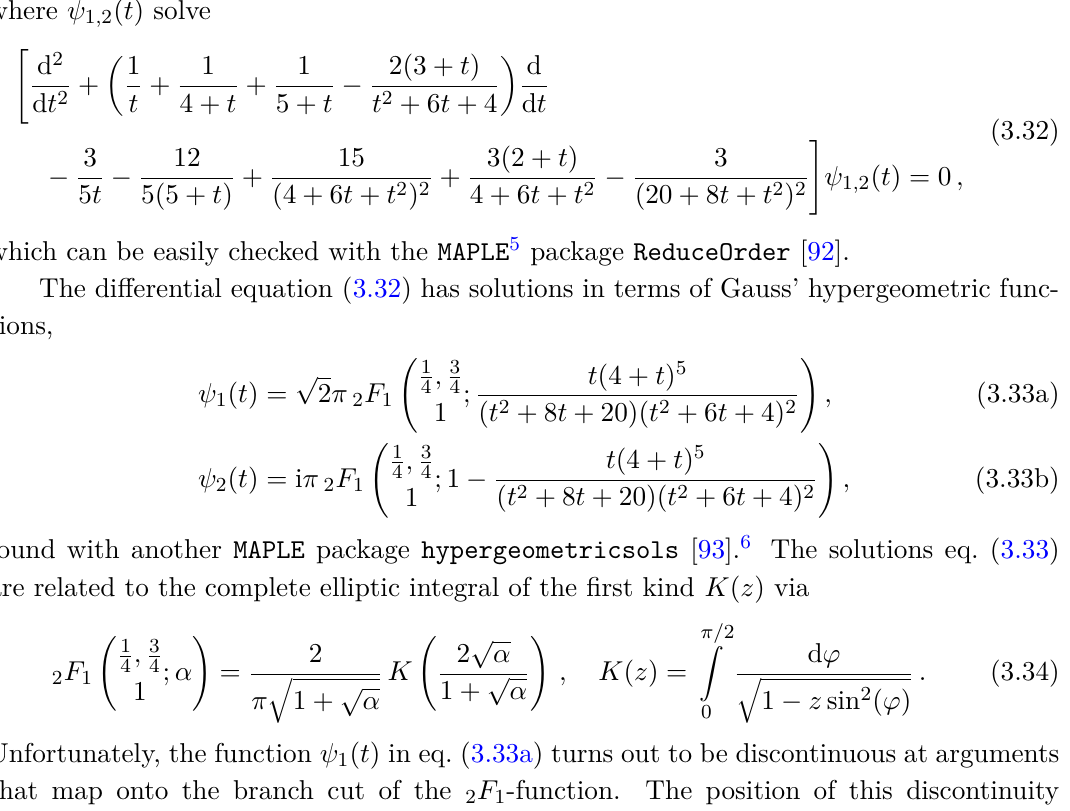
Figure 5. The function ψ 1 ( x ) has discontinuities for x in the upper complex half-plane at the blue line which touches the real axis at x = − 9 + 4 continuous solution, one has to distinguish between the inner and outer region shown in the